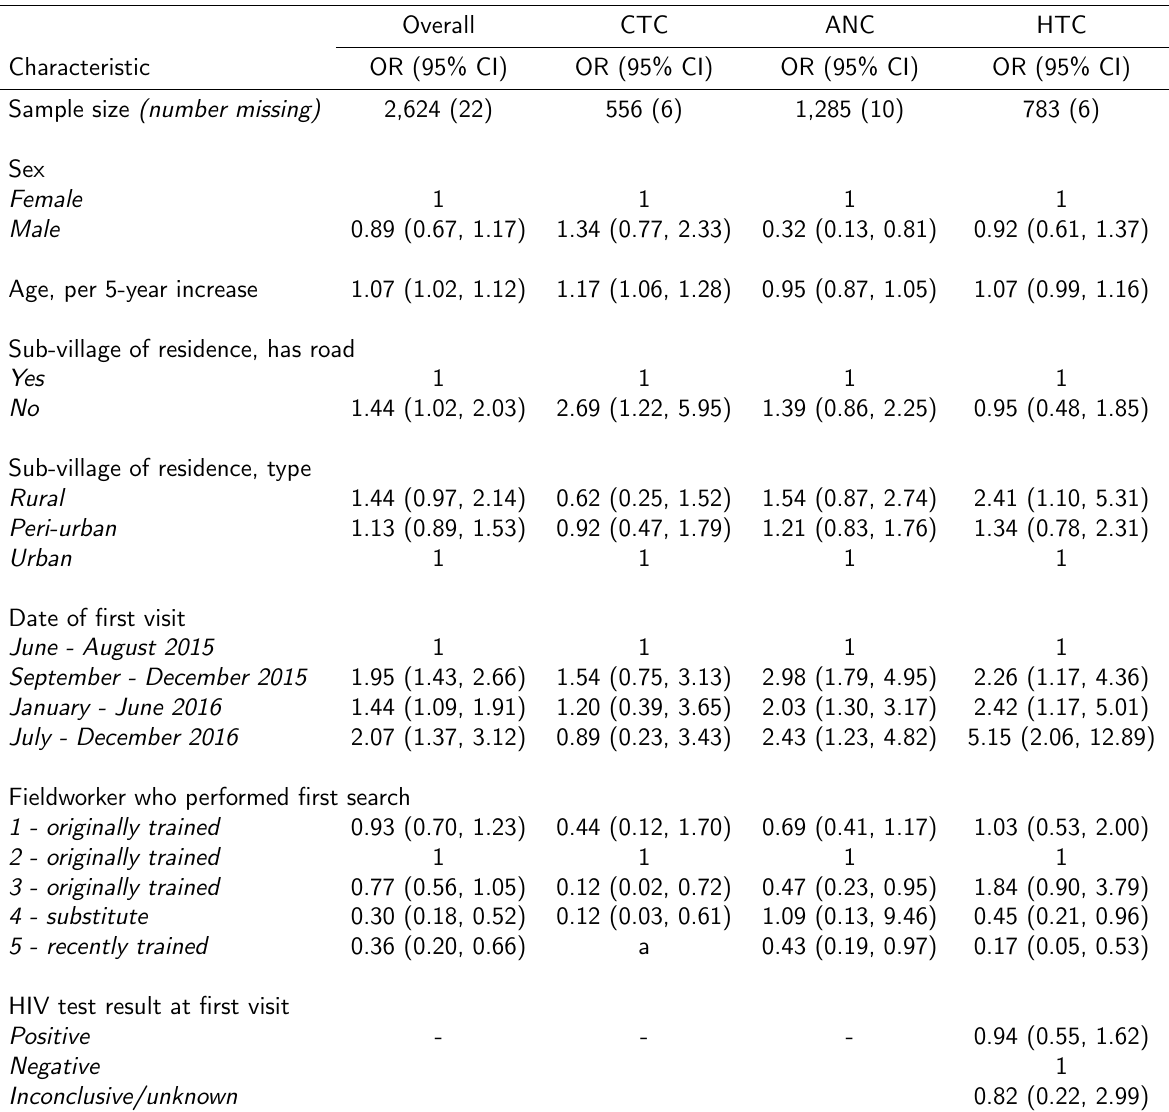
Table 3: Results from multivariable logistic regression models estimating the associations between being matched to an HDSS record with various patient characteristics in rural Tanzania, overall and by